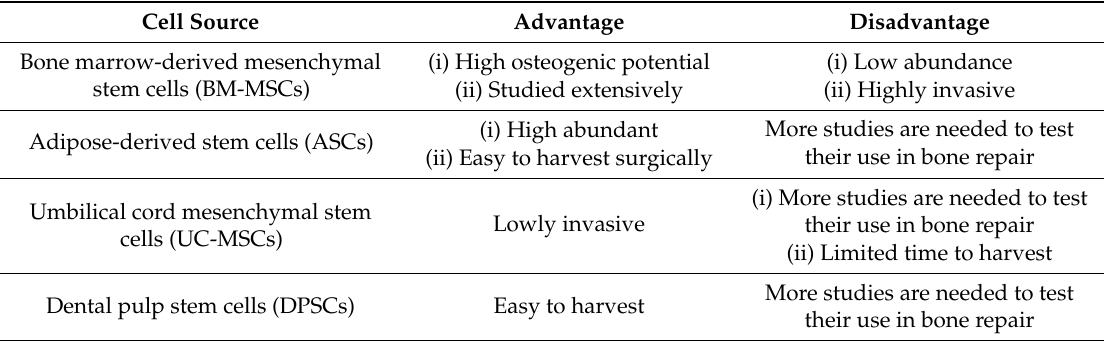
Table 1. Cell source of mesenchymal cells (MSCs) used for bone tissue regeneration [27].